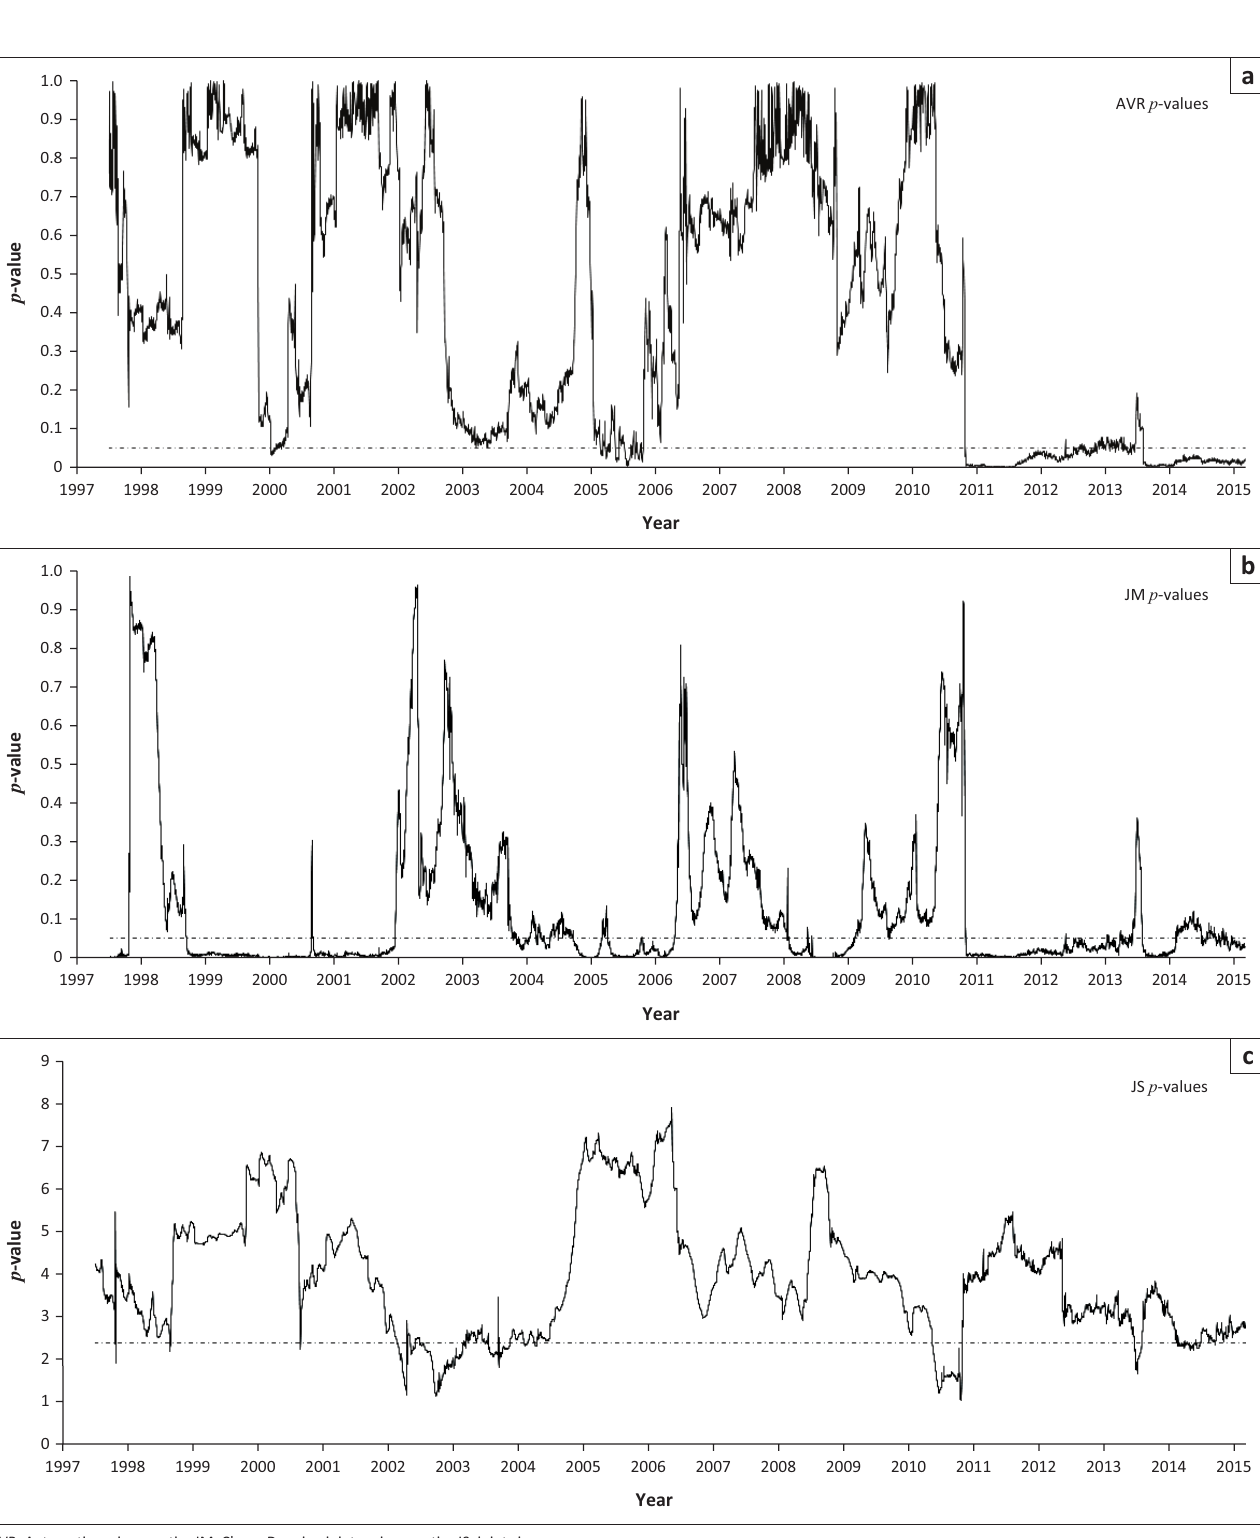
FIGURE 5: J202 – Small cap index: (a) AVR p -values, (b) JM p -values, (c) JS p